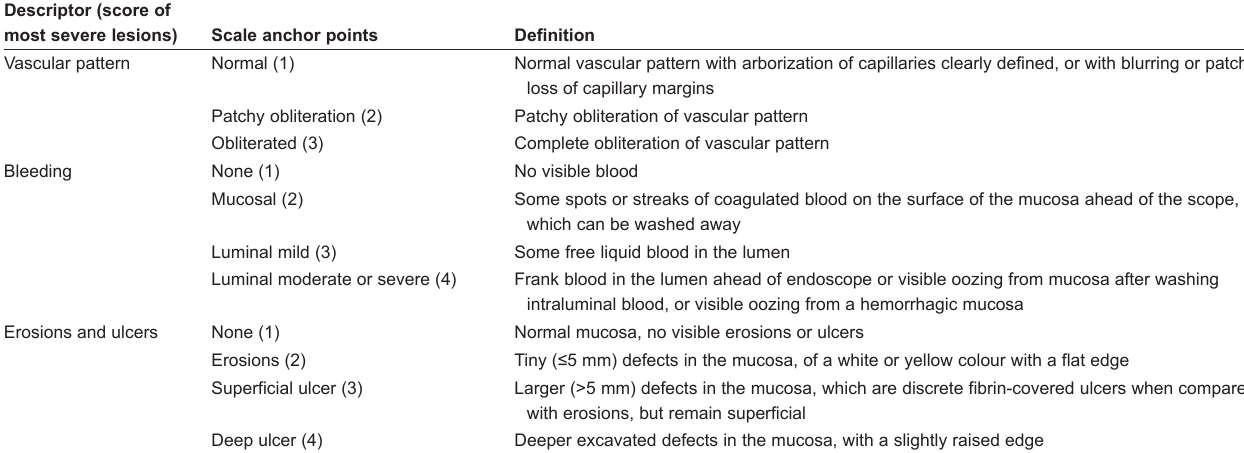
TAble 1 Ulcerative Colitis endoscopic Index of Severity (UCeIS) Descriptor (score